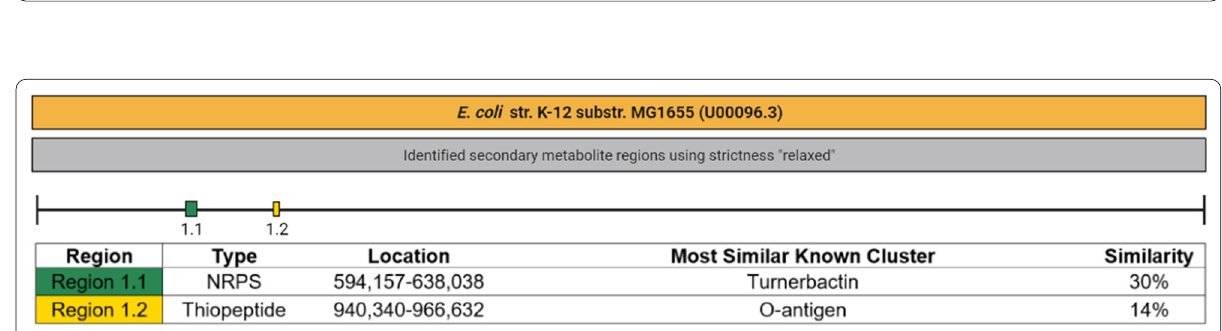
Fig. 4 Predicted secondary metabolites in E. coli strain K-12 sub strain MG1655 (NCBI Accession number: